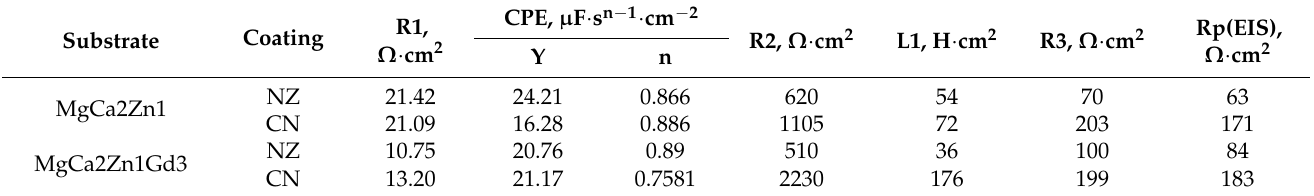
Table 3. Impedance parameters (EIS) of the conversion coating with casein (CN) and casein-free coating (NZ) in the MgCa2Zn1 and MgCa2Zn1Gd3